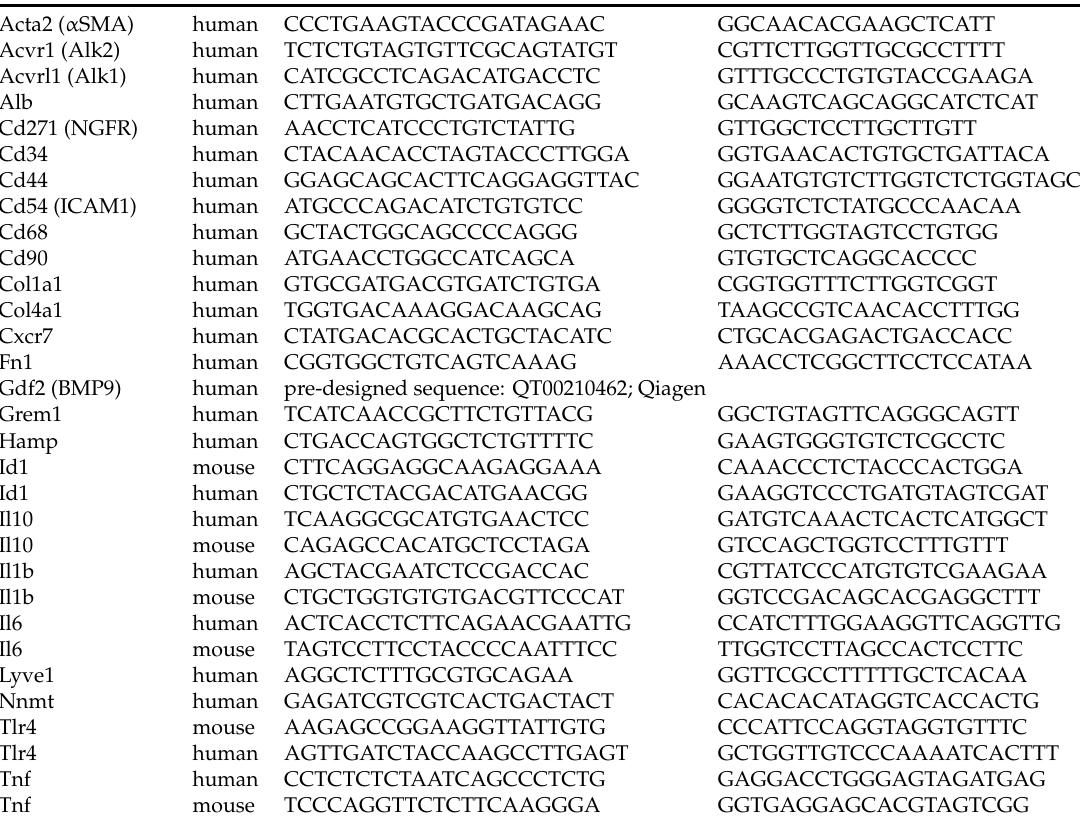
Table 1. Sequences of the primers used for RT-qPCR (5 (cid:48) → 3 (cid:48)